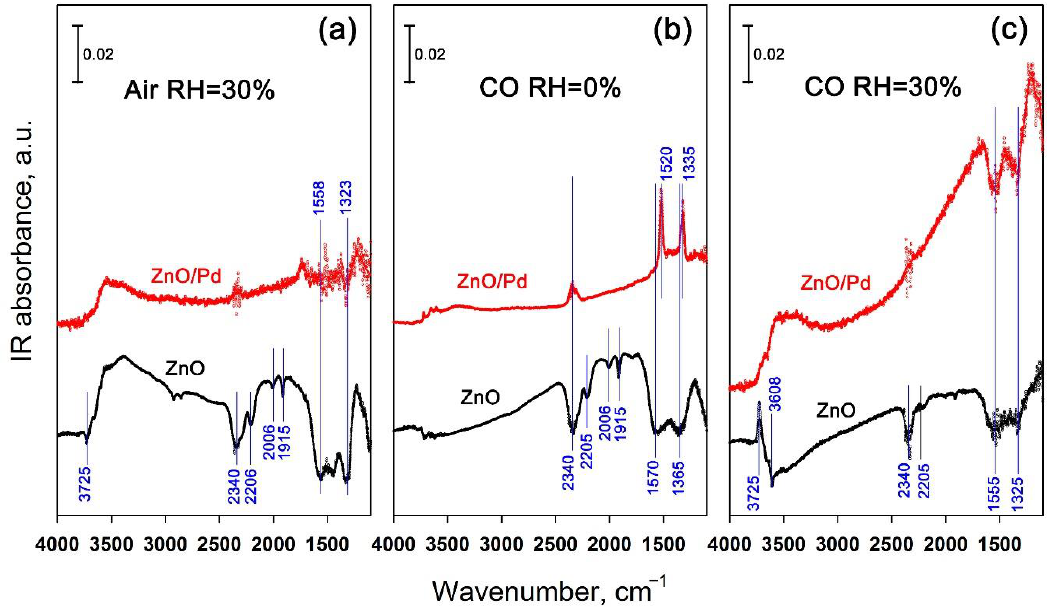
Figure 8. Diffuse reflectance IR Fourier transform spectroscopy (DRIFTS) of ZnO and ZnO/Pd nanofibers in humid air ( a ), in the presence of 500 ppm CO in dry air (RH 25 = 0%) ( b ), in the presence of 500 ppm CO in humid air (RH 25 = 60%) ( c ).